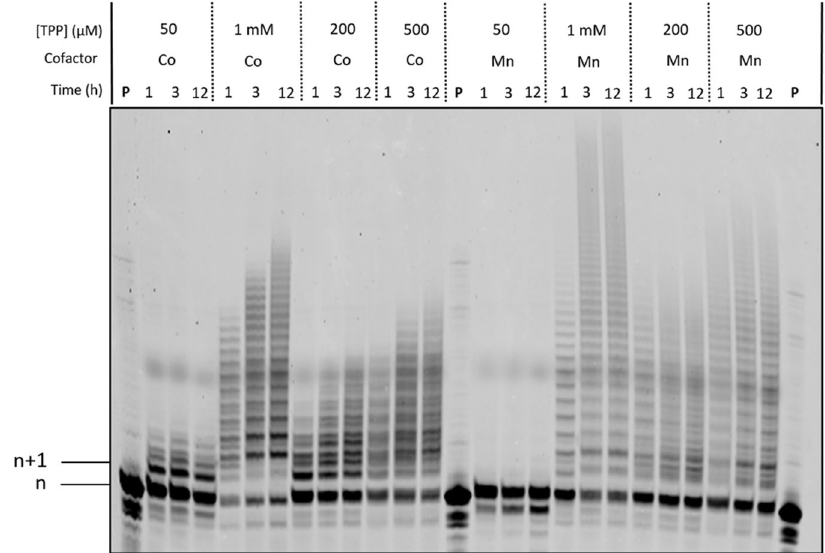
Fig. 7 Evaluation of modi fi ed nucleotide 12 under TdT-mediated reactions. Gel image (PAGE 20%) shows the results of the TdT-mediated extension reactions with 3 ′ - β -cyanophosphate-LNA-TTP 12 and primer P2 (20 pmoles). Reaction mixtures contained TdT (10 U), triphosphate at various, given concentrations, Co 2 + (0.25 mM) or Mn 2 + (1 mM) cofactors, and were incubated at 37 °C for given reaction times. P represents unreacted, 5 ′ -FAM- labeled primer.